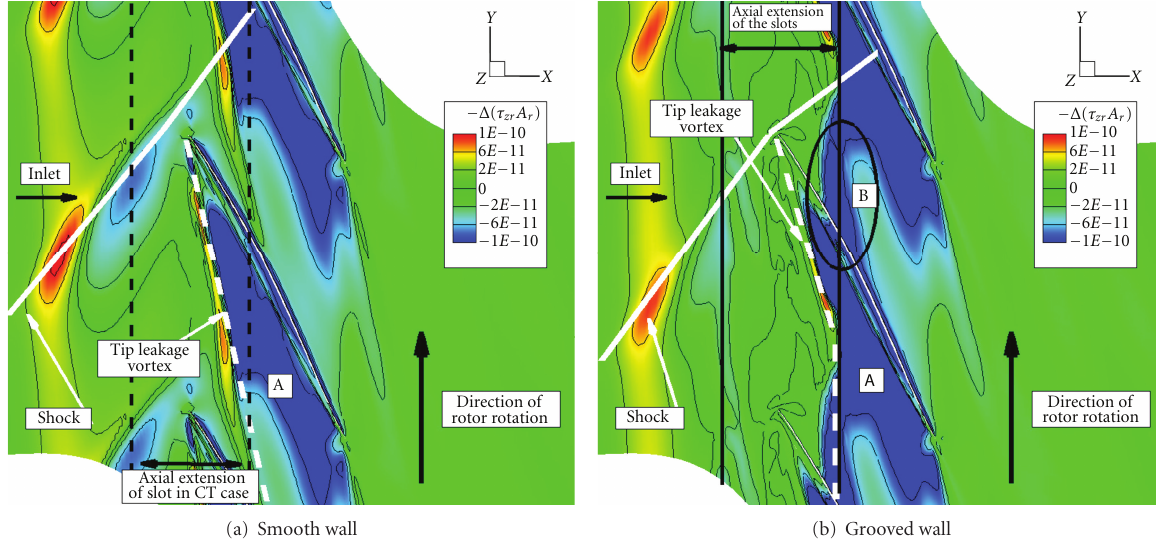
Figure 19: CBUAA: Flow field denoted at midgap by negative values of − Δ ( τ zr A r ).